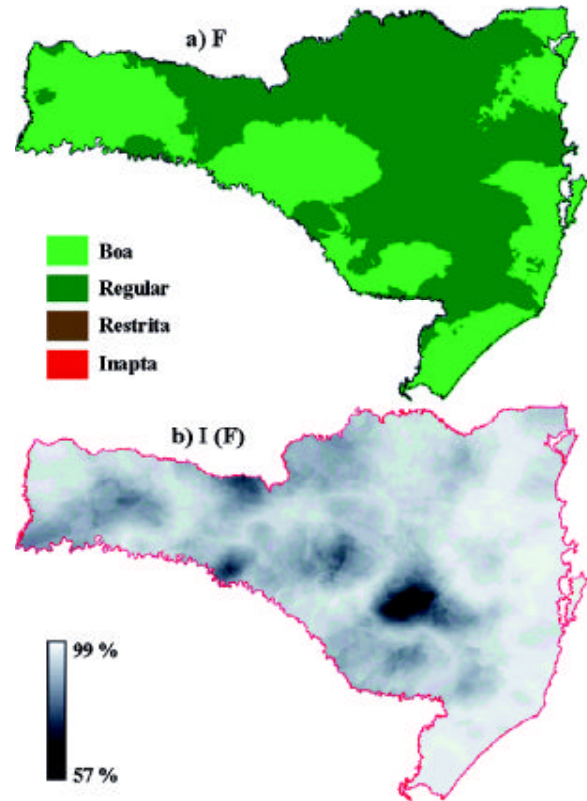
Figura 4. Espacialização de limitação em fertilidade e da incerteza associada, obtida a partir da integração dos atributos categóricos K, Al, V, S e CTC por meio de álgebra de mapas por meio de procedimentos booleanos